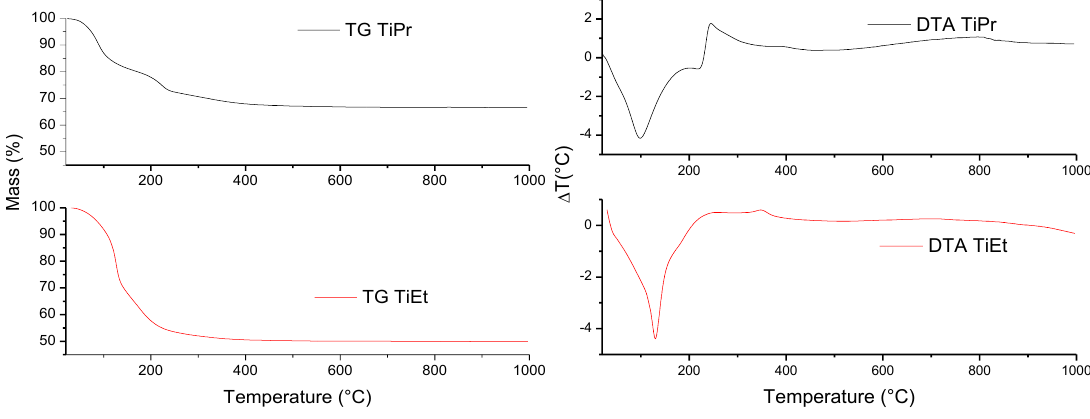
Figure 4. TG and DTA curves of samples TiEt and TiPr.